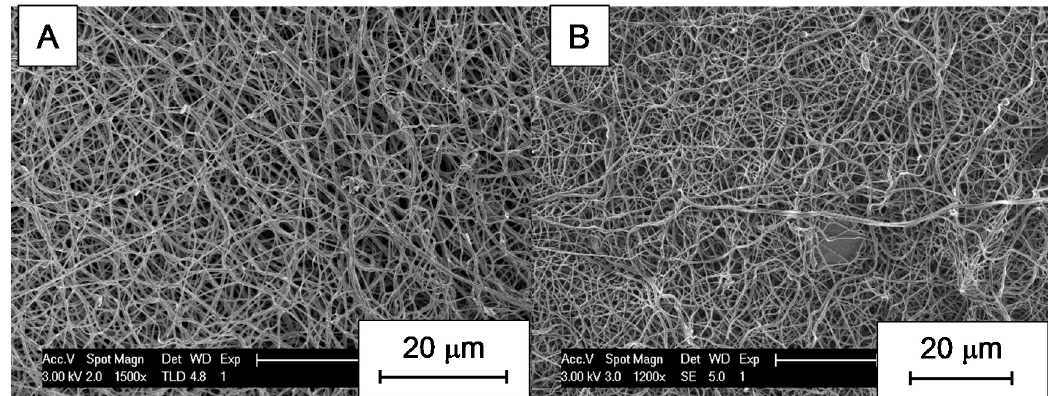
Figure 3. SEM micrographs of materials obtained from KL at different voltages: ( A ) 7 kV; ( B ) 9 kV.